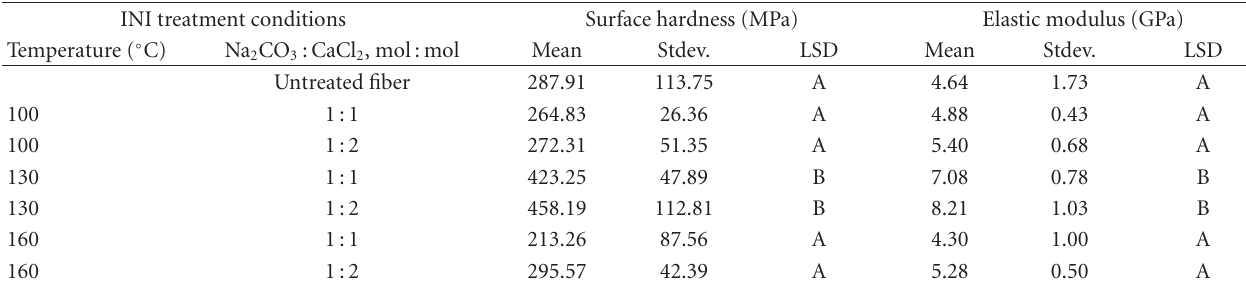
Table 2: Surface hardness and elastic modulus of the INI treated fibers.